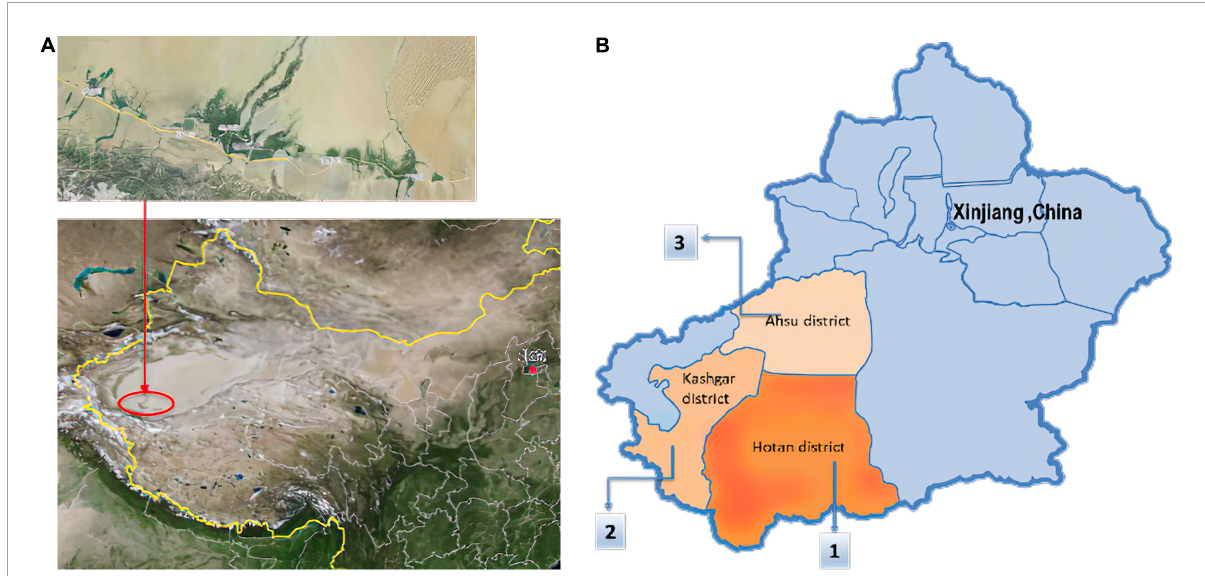
FIGURE1 Anjian chickens are mainly distributed in the south of Xinjiang, China. (A) They are located in the northern foothills of the Kunlun Mountains and in Hotan Prefecture, in the southern region of the Taklimakan Desert. (B) Distribution of Anjian chickens: (1). In Hotan Prefecture (region of origin); (2). A small number of chickens are distributed in Shache County, Maigaiti, and four counties in the Kashgar area; (3). Aksu Prefecture has started breeding in recent